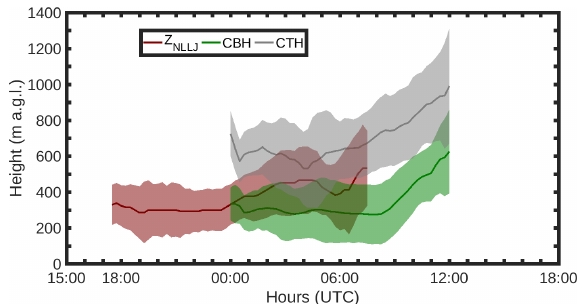
Figure 12. Median diurnal cycle of the NLLJ core height (solid red line), cloud base height (solid green line) and cloud top height (solid grey line) from 20 June to 30 July 2016 at the Savè supersite. Shaded areas indicate variability ( ± σ